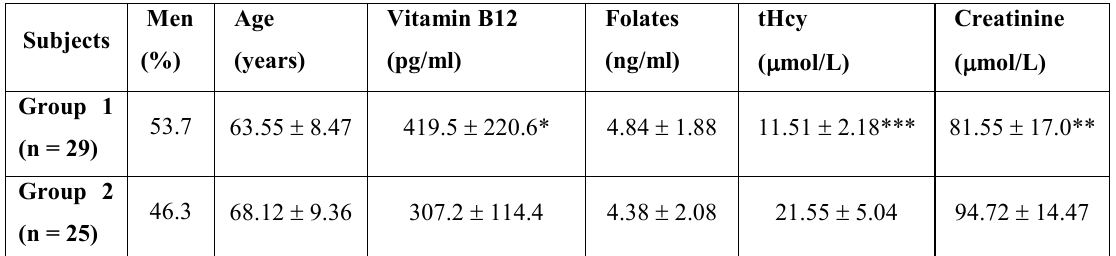
Table 2. Comparison of biological markers in the two groups with low (Group 1: tHcy < 15 µ mol/L) or